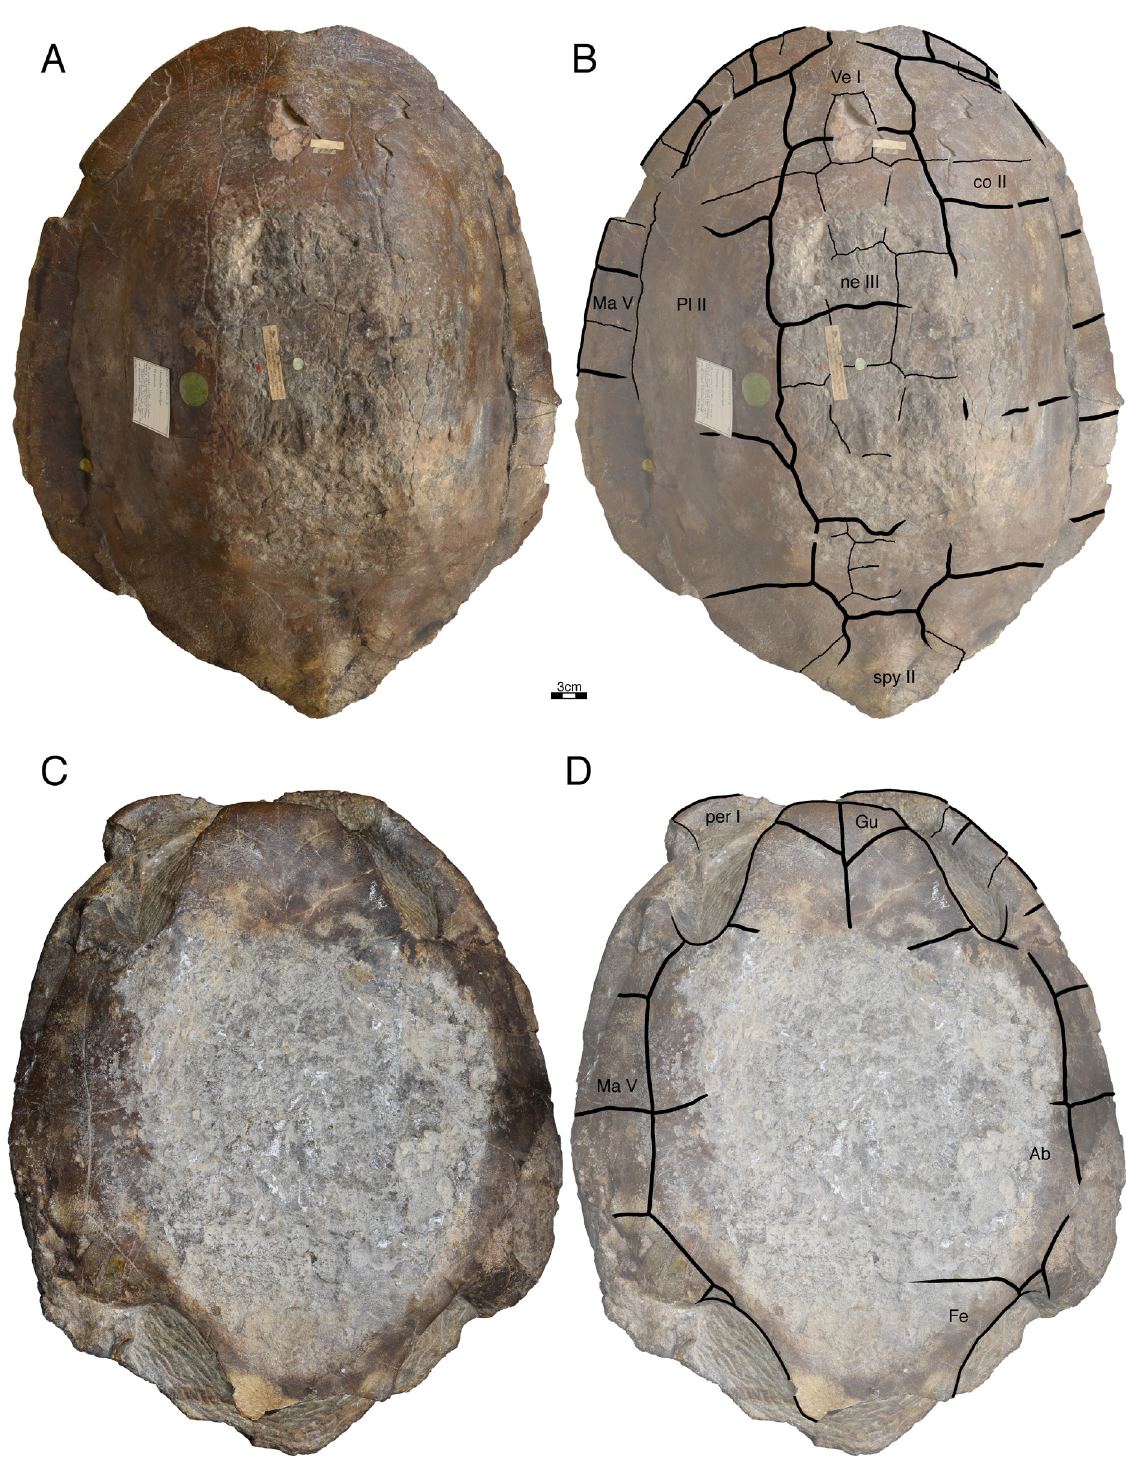
Fig. 10. BMNH 39834, holotype of Batagur cautleyi Lydekker 1885, here identified as Batagur sp. A . Photograph of carapace. B . Illustration of carapace. C . Photograph of plastron. D . Illustration of plastron. Scale bar: 3